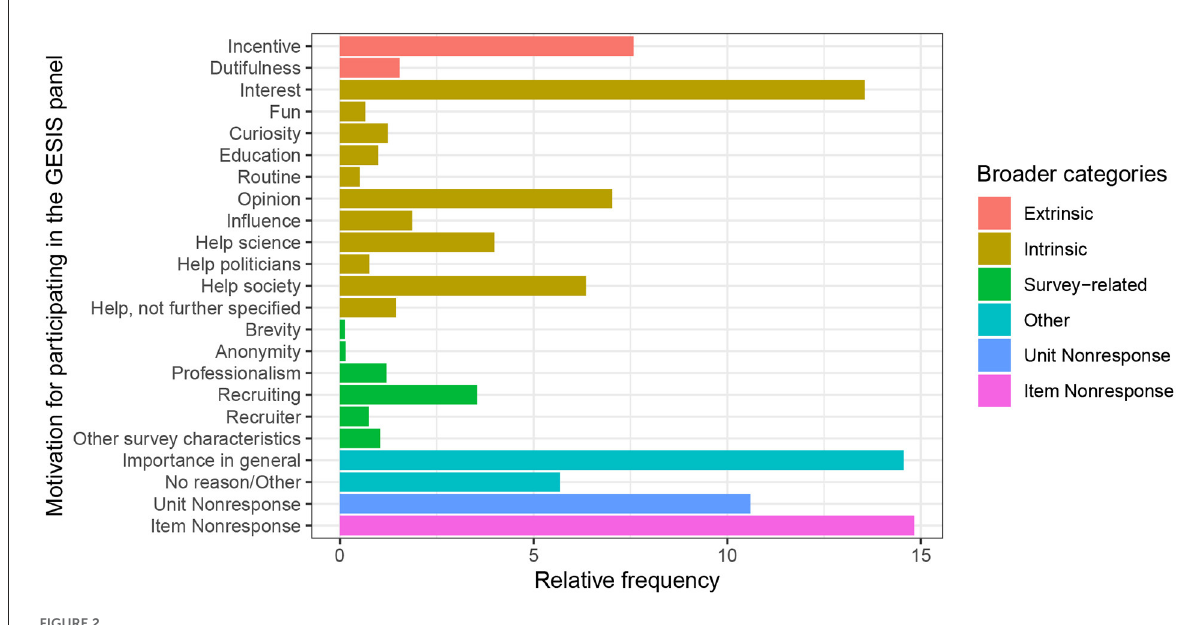
FIGURE2 Most important reason given by panelists in wave “bf” (2014) of the GESIS Panel. Semi-automated classification of reasons described in Section